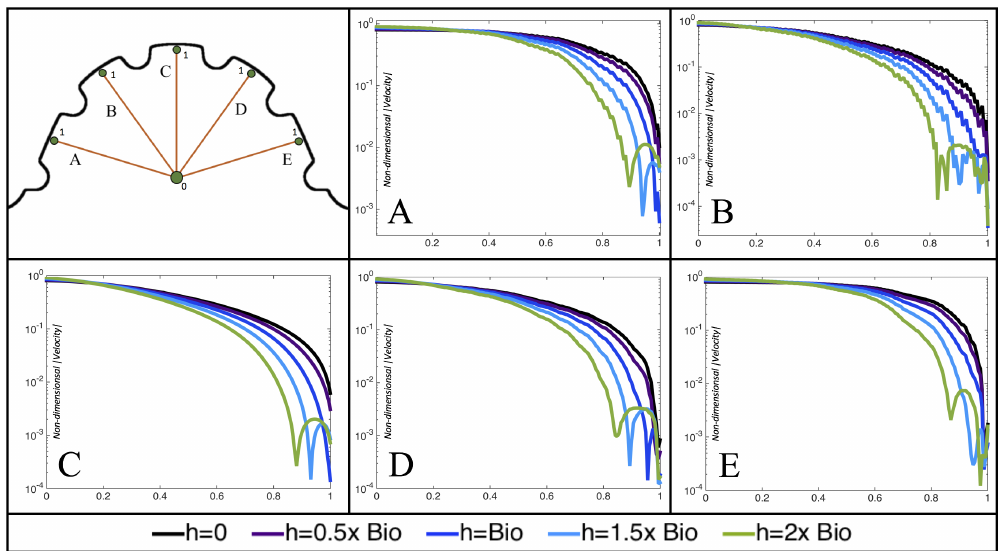
Figure A6. Measurements of the non-dimensional magnitude of velocity are provided for the Re = 10 case quantified along a line from the intracardial center (labeled “0”) and extending to the ventricular lining (labeled “1”) for various intertrabecular regions and trabeculae heights. The velocity strictly decreases from the center until around the neighboring trabeculae heights, in which the velocity increases, in some cases, an order of magnitude, before dropping towards zero at the ventricle